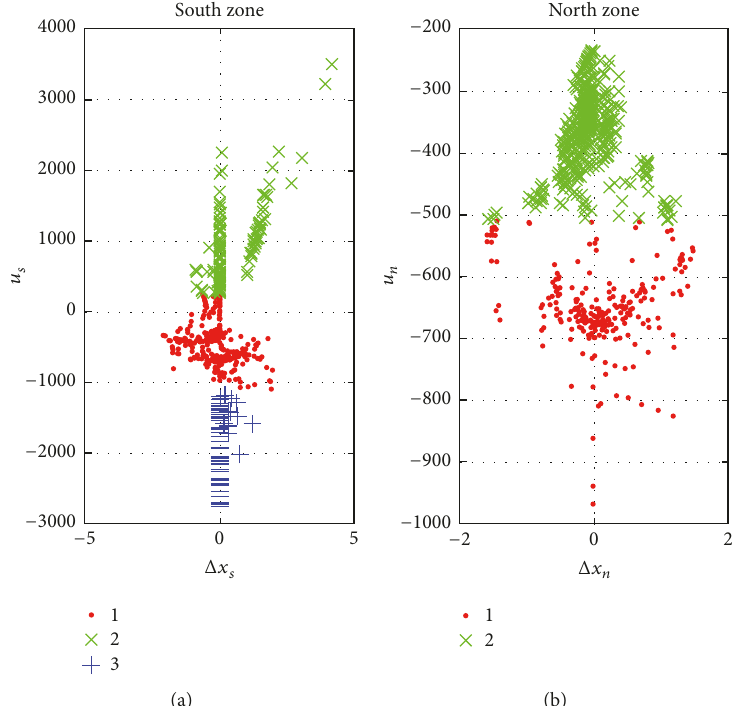
Figure 16: 𝐾 -means clustering of the south and the north zones.